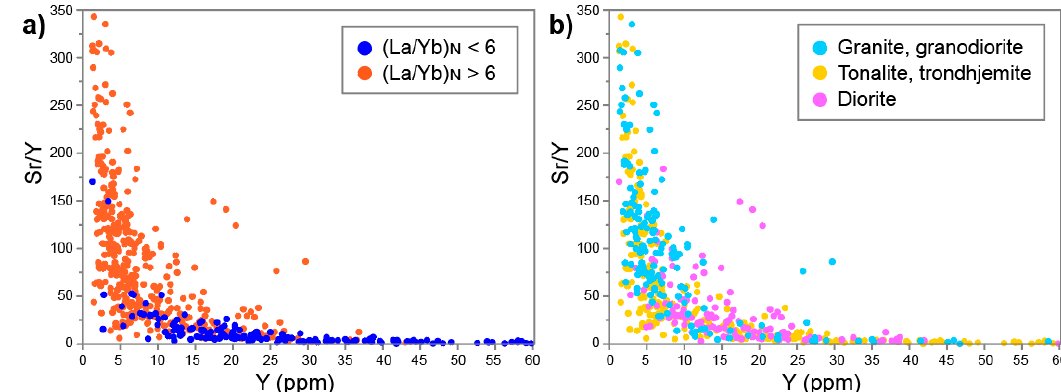
Figure 8. Chemistry of intermediate-felsic intrusive rocks of the Sigeom dataset displayed on the Sr / Y vs. Y binary diagram. Only rocks recognized as granite, granodiorite, tonalite, trondhjemite, and diorite in the field, with REE, Y, and Sr analyzed, are displayed ( n = 558). Color code corresponds to the HREE content ( a ) and field-based names ( b ).